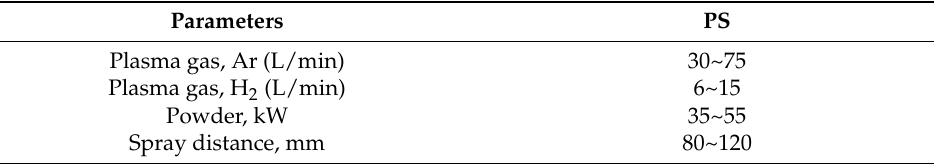
Table 1. Spraying parameters of plasma spraying